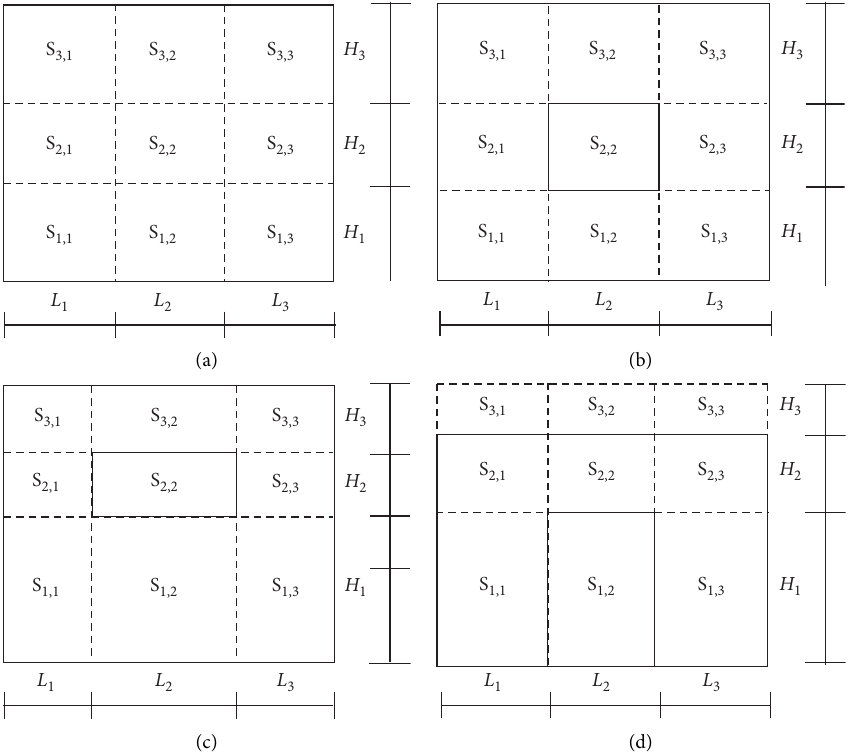
Figure 2: CA model: (a) for the solid panel and (b), (c), and (d) for panels with an opening according to available experimental